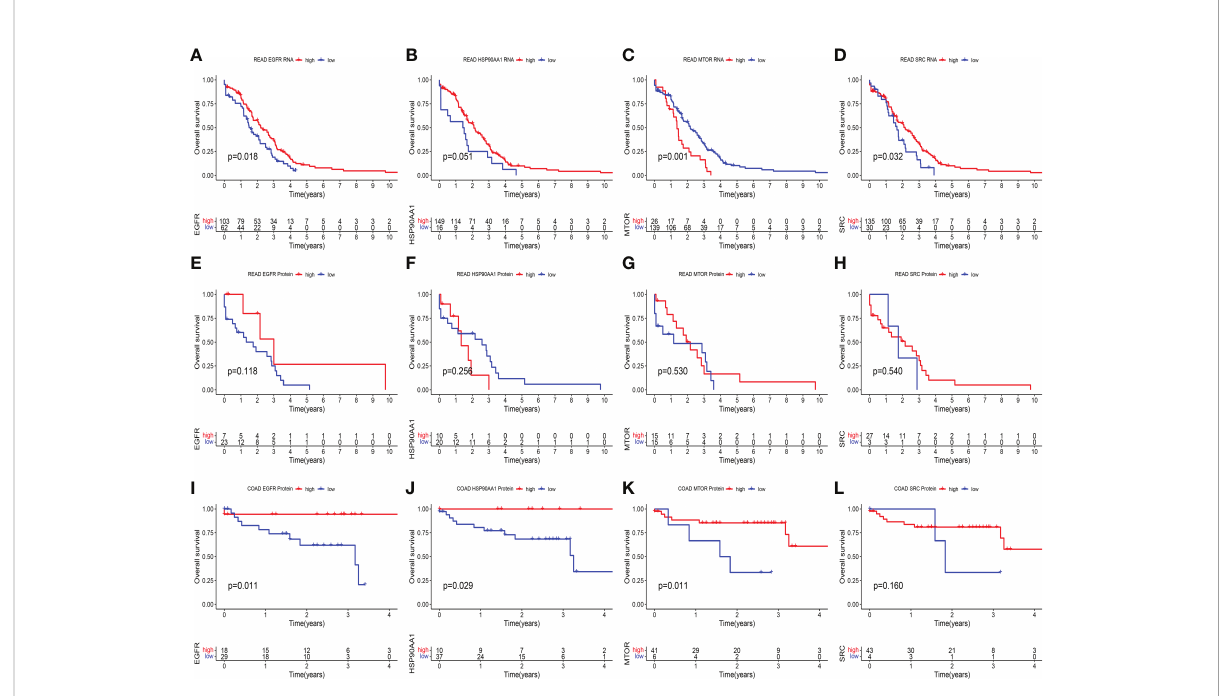
FIGURE 7 Kaplan – Meier survival analysis in different expression groups of key genes at the protein and transcript levels. (A – D) At transcriptional level of RC, Kaplan-Meier curves showed the overall survival difference between high and expression group of EGFR ( p = 0.018) (A) , HSP90AA1 ( p = 0.051) (B) , MTOR ( p = 0.001) (C) and SRC ( p = 0.032) (D) . (E – H) At protein level of RC, Kaplan-Meier curves showed the overall survival difference between high and low expression group of EGFR ( p = 0.118) (E) , HSP90AA1 ( p = 0.256) (F) , MTOR ( p = 0.530) (G) and SRC ( p = 0.540)